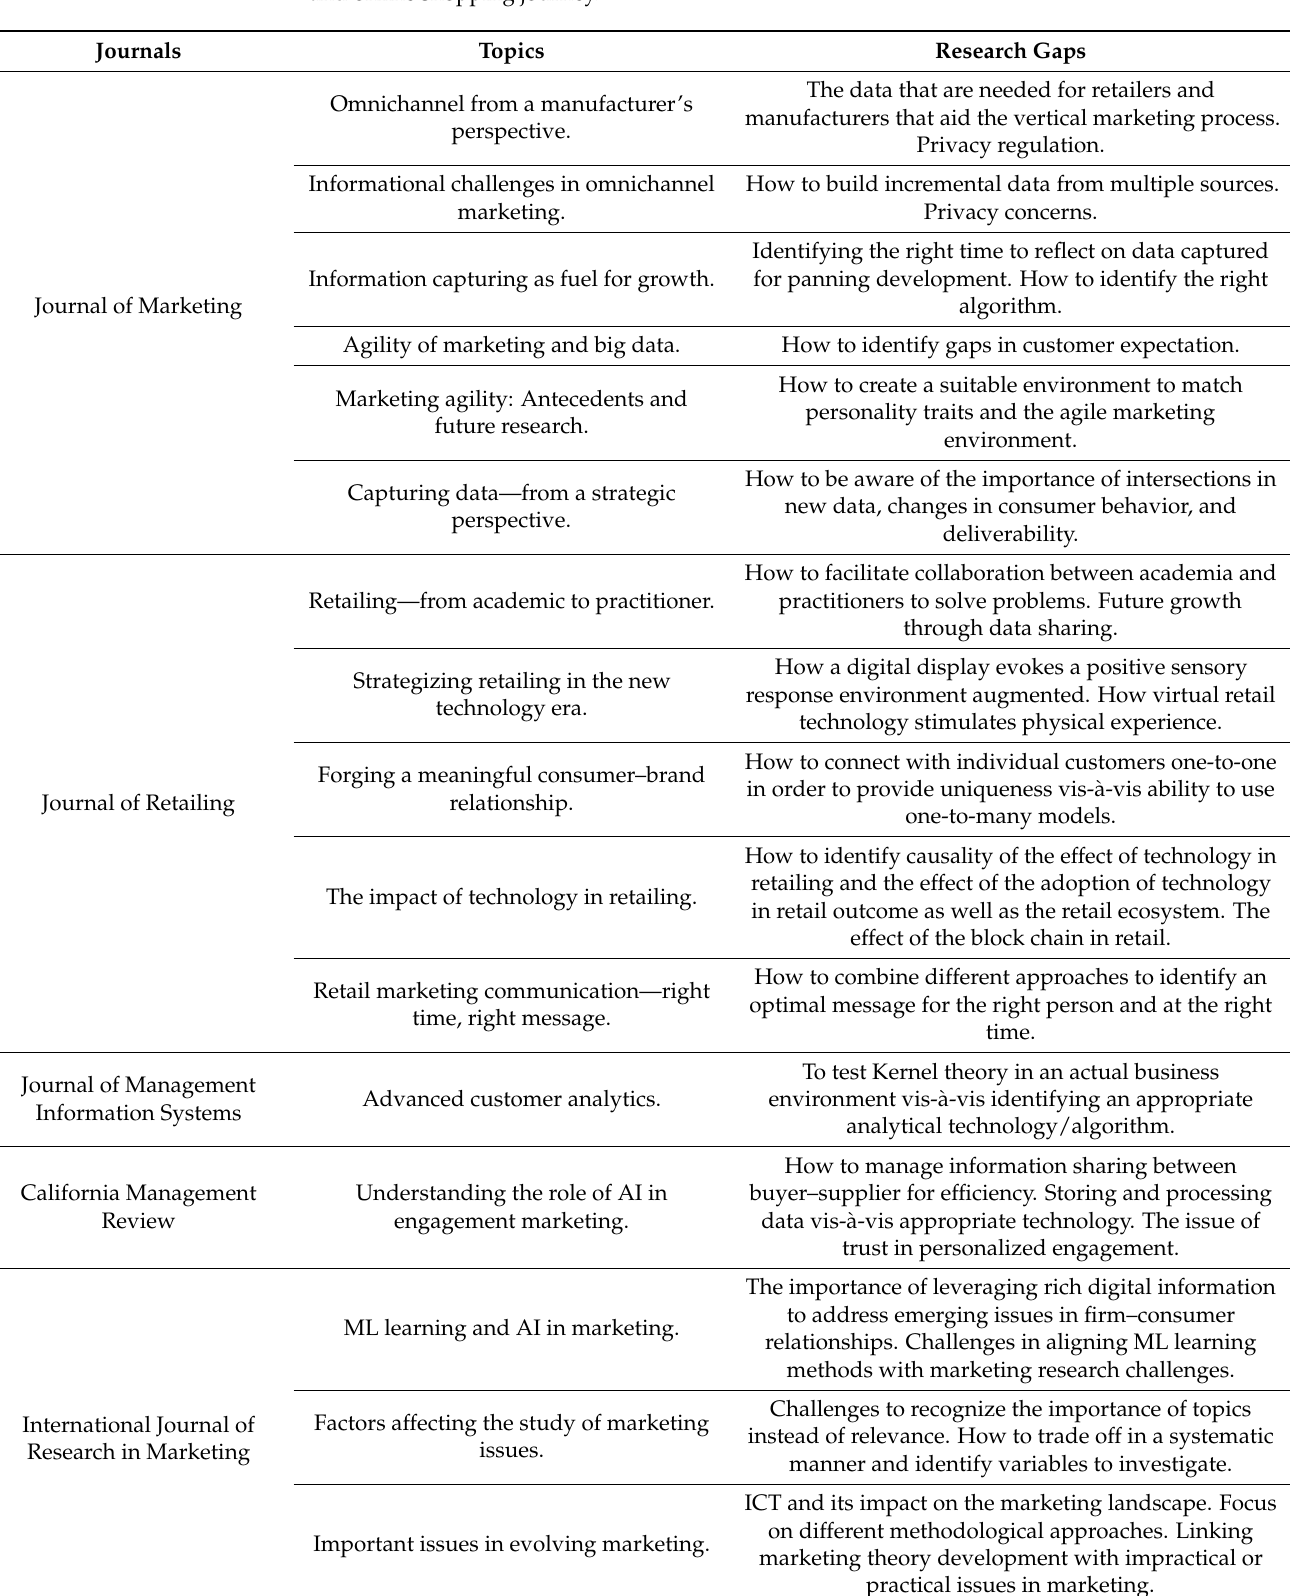
Table 1. List of most influential academic journals with the key research gaps identified: AI, AIDA, and online shopping